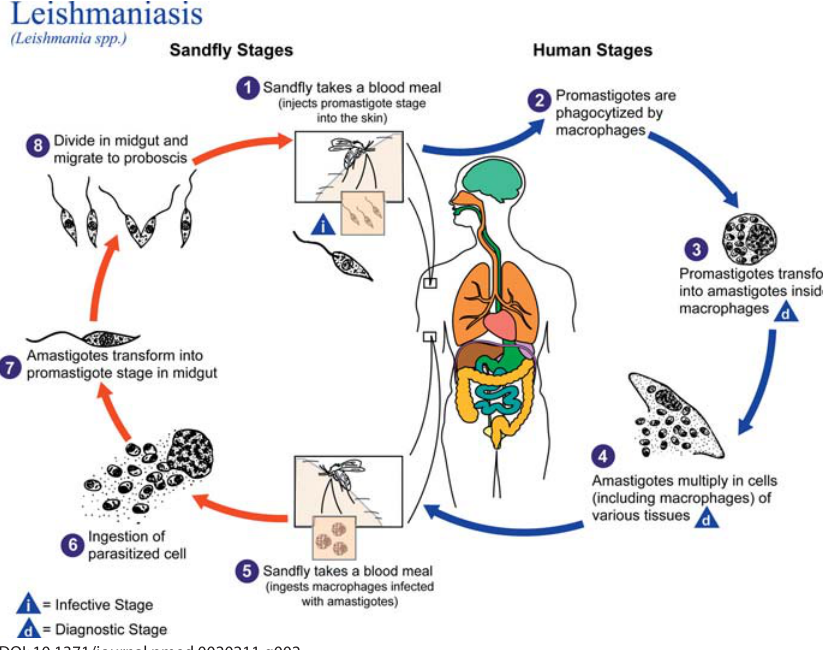
Figure 2. The Life Cycle of Leishmania spp., the Causal Agents of Leishmaniasis Leishmaniasis is transmitted by the bite of female phlebotomine sandfl ies. The sandfl ies inject the infective stage, promastigotes, during blood meals (1). Promastigotes that reach the puncture wound are phagocytized by macrophages (2) and transform into amastigotes (3). Amastigotes multiply in infected cells and affect different tissues, depending in part on the Leishmania species (4). This originates the clinical manifestations of leishmaniasis. Sandfl ies become infected during blood meals on an infected host when they ingest macrophages infected with amastigotes (5 and 6). In the sandfl y’s midgut, the parasites differentiate into promastigotes (7), which multiply and migrate to the proboscis (8). (Illustration: CDC/Alexander J da Silva/Melanie